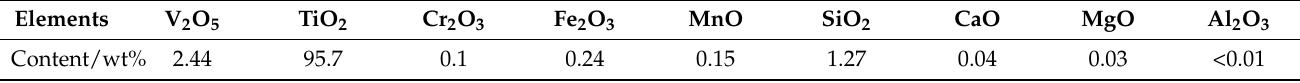
Table 2. Chemical composition of the product